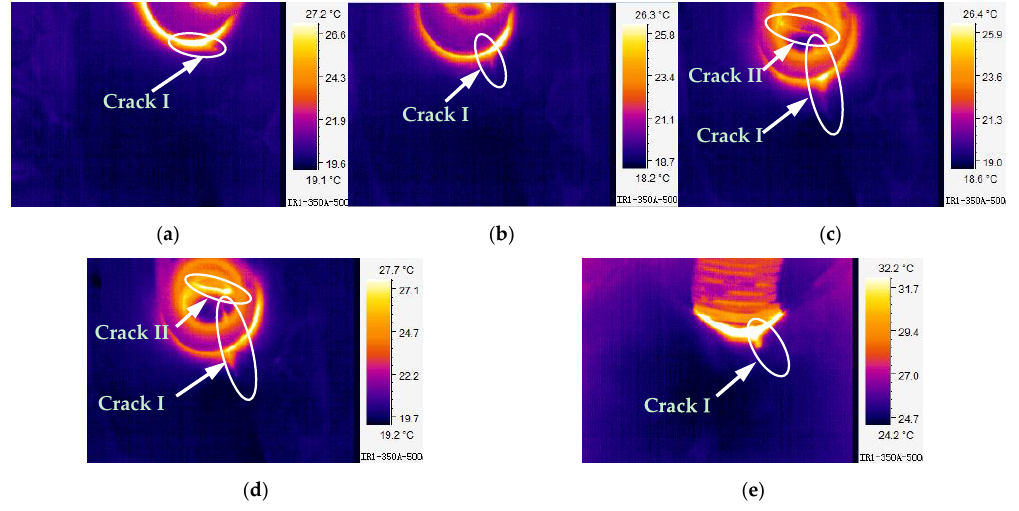
Figure 7. IR images recorded when the coil is placed at ( a ) Position A, ( b ) Position B, ( c ) Position C, ( d ) Position D, and ( e ) Position E. Positions A~E is corresponding to Figure 4b.